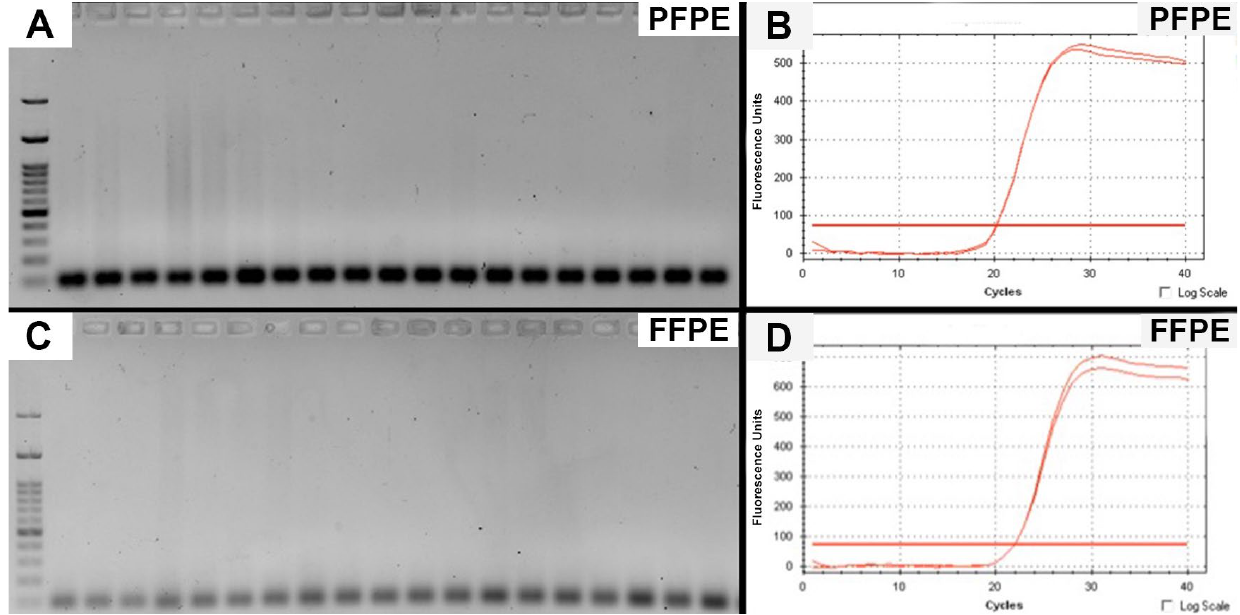
Figure 2. qPCR was performed on paired DNA samples in duplicate using primers for the YWHAZ gene. Gel electrophoresis demonstrated crisp bands at 100 bp, indicative of amplified PCR products obtained in both FFPE and PFPE samples ( A , C ). In all cases, PFPE samples demonstrated a significantly lower Cq value, indicative of a higher starting concentration of amplifiable DNA. Representative melt curves from one of pair samples are shown in ( B , D ). FFPE = formalin-fixed, paraffin-embedded; PFPE = PAXgene-fixed, paraffin-embedded.